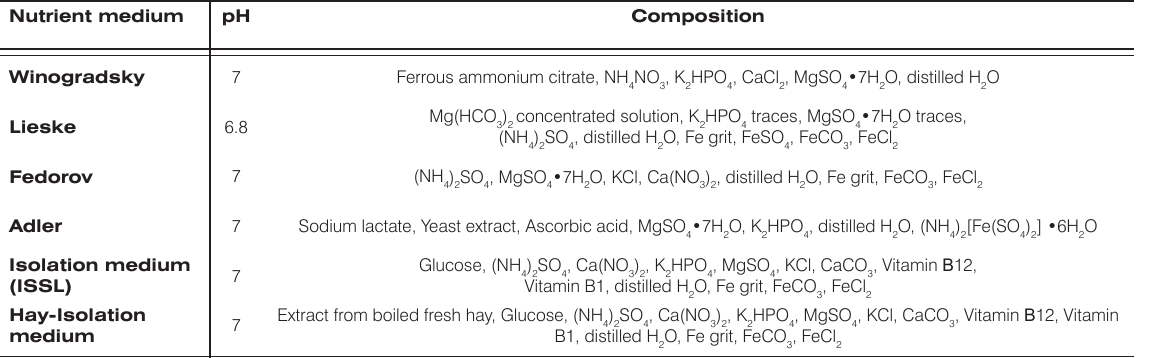
Table 1. Composition of nutrient media used. Nutrient medium pH